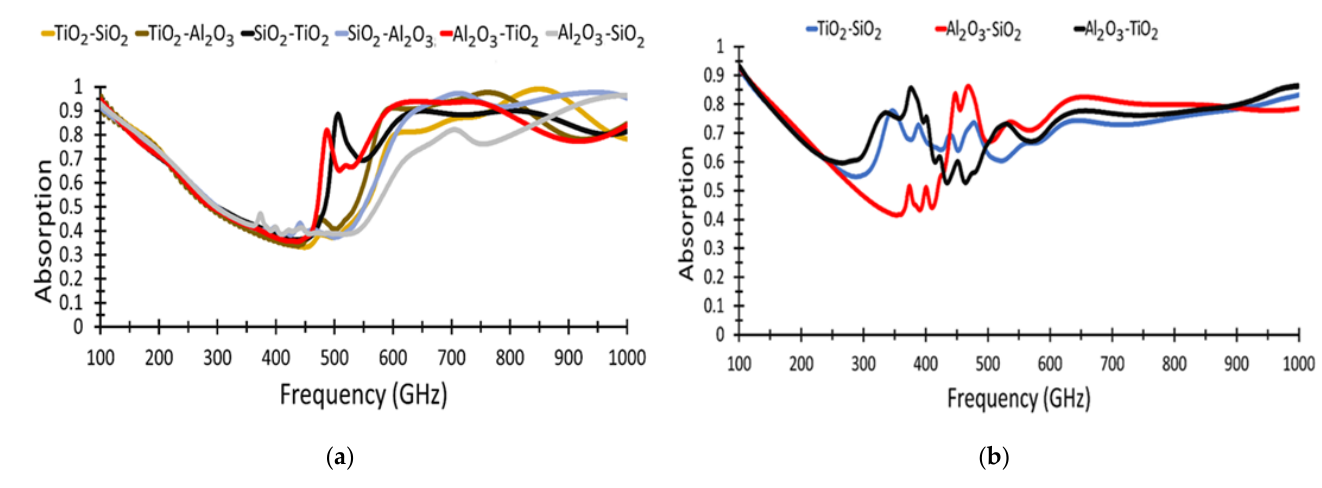
Figure 6. Absorption of the multi-dielectric layers MMA structure: ( a ) Two dielectric layers on top of each other; ( b ) Two side-by-side dielectric layers. Table 2. Absorption for different dielectric substrates.